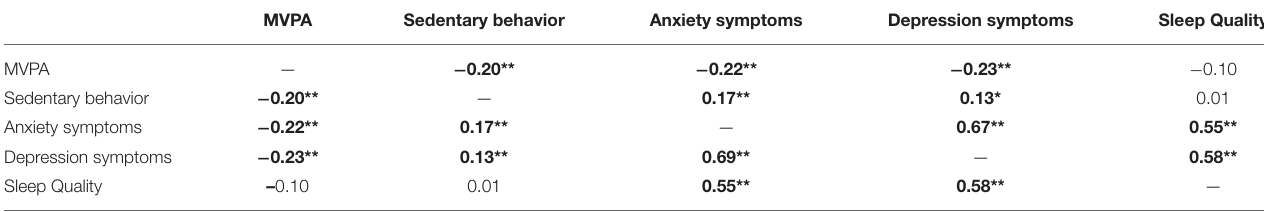
TABLE 5 | Relationship (Spearman Correlation) between MVPA, SB, Anxiety symptoms, Depression symptoms, and Sleep Quality. MVPA Sedentary behavior Anxiety